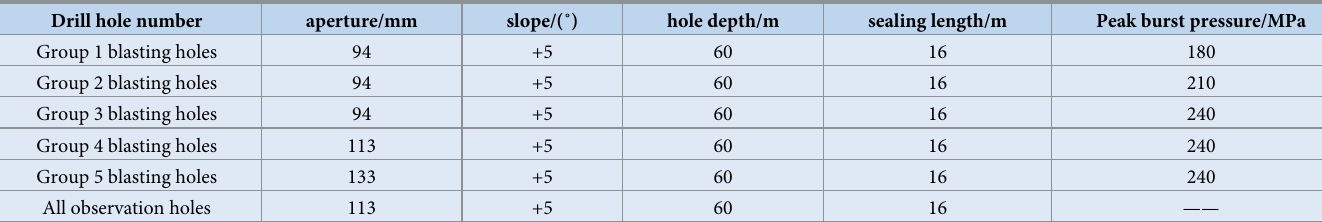
Table 5. Test hole layout parameters.